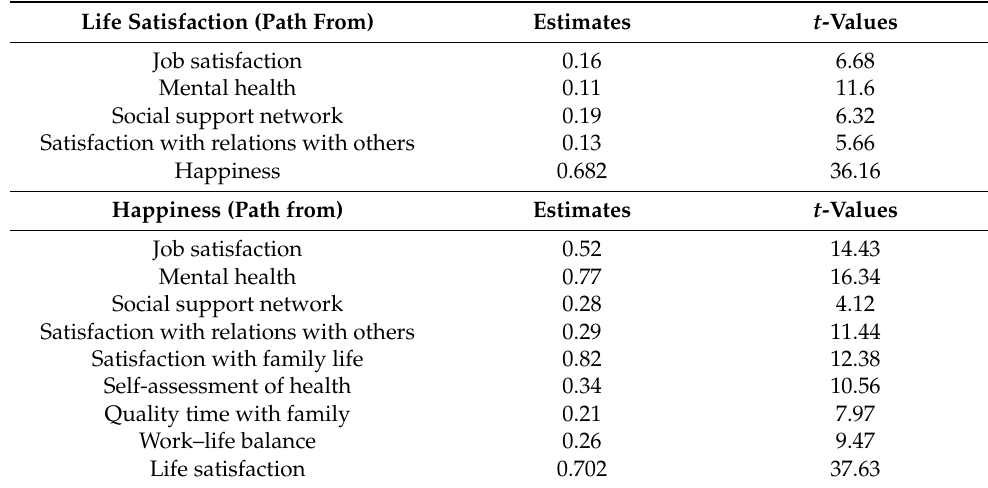
Table 6. Path analysis model—specifications.